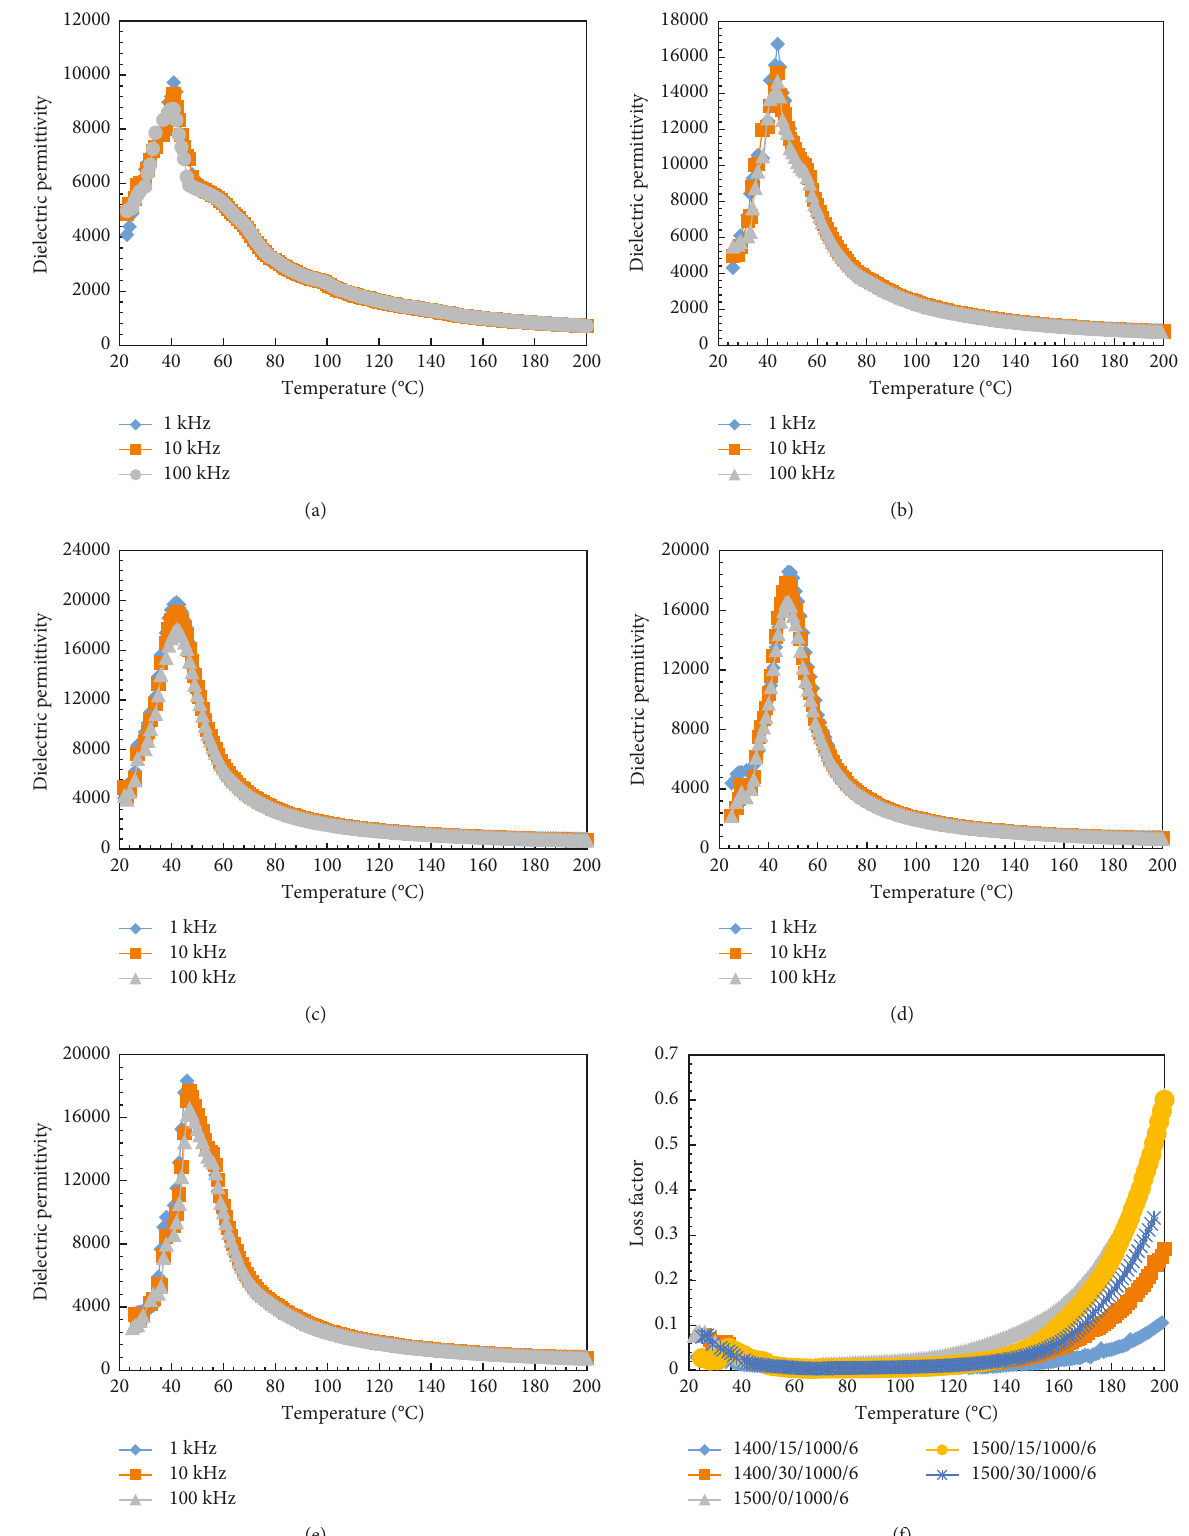
Figure 3: The temperature dependence of dielectric permittivity of BTS ceramics sintered at different conditions at frequencies of 1, 10, and 100kHz: (a) “1400/15/1000/6”; (b) “1400/30/1000/6”; (c) “1500/0/1000/6”; (d) “1500/15/1000/6”; (e) “1500/30/1000/6”; (f) loss factor (tan δ ) of the BTS ceramics at